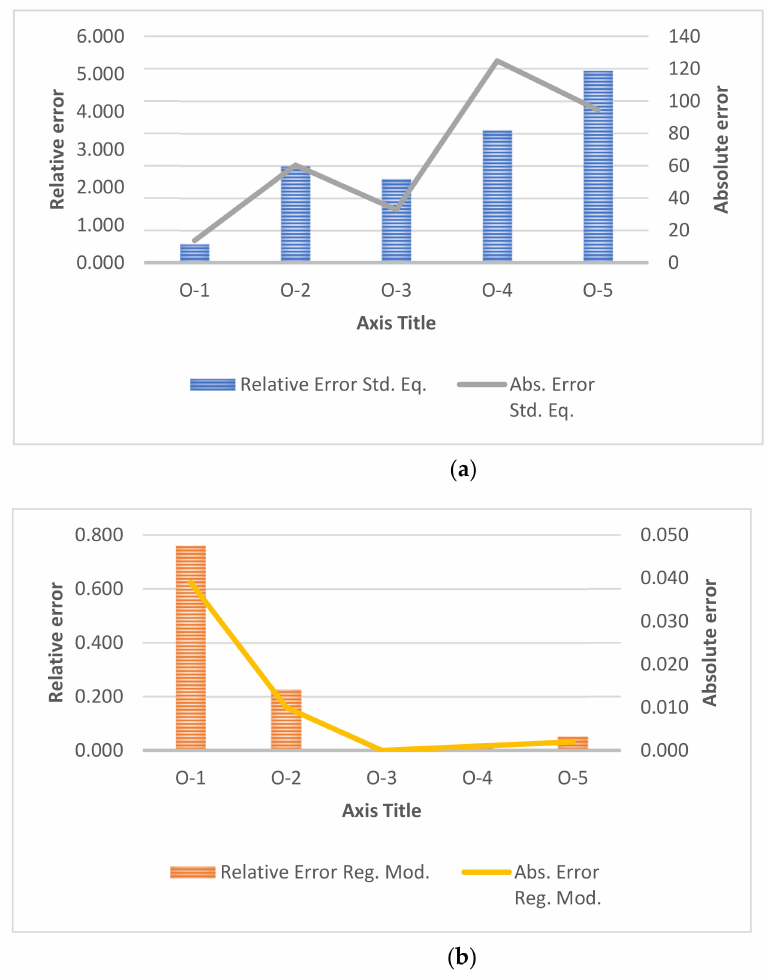
Figure 9. ( a ). Relative and absolute error of experimental and standard equation values. ( b ) Relative and absolute error of experimental and regression equation